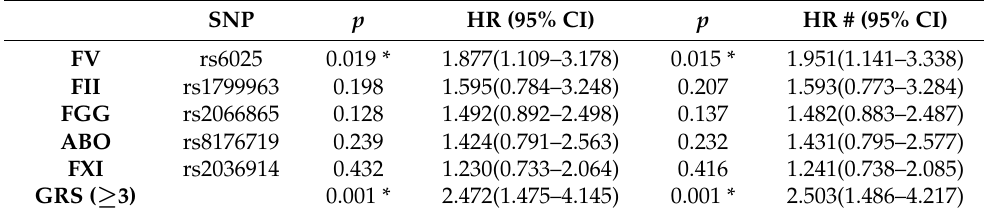
Table 5. The Risk of Recurrent VTE Associated With the five SNPs among the two studied groups of patients.